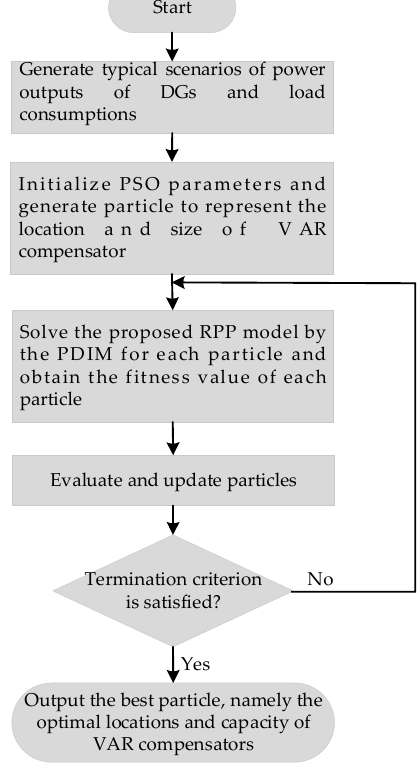
Figure 5. The flow chart of proposed algorithm.